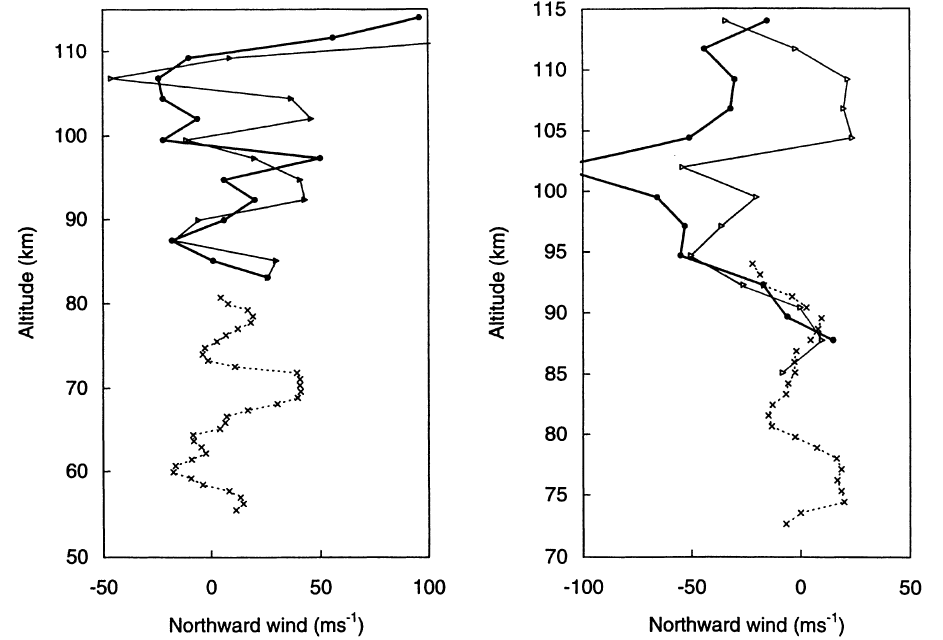
reliable than that from the SE position ( (cid:110) ) if there is a significant zonal wind present. The uncertainties for the VHF results are no more than a few m s ) 1 while for the UHF they are probably at least (cid:139)20 m s ) 1 (see text). Left: VHF at elevation 45 (cid:176) (–x–), 1542 UT. Right: VHF at elevation 58 (cid:176) (–x–), 2000 UT